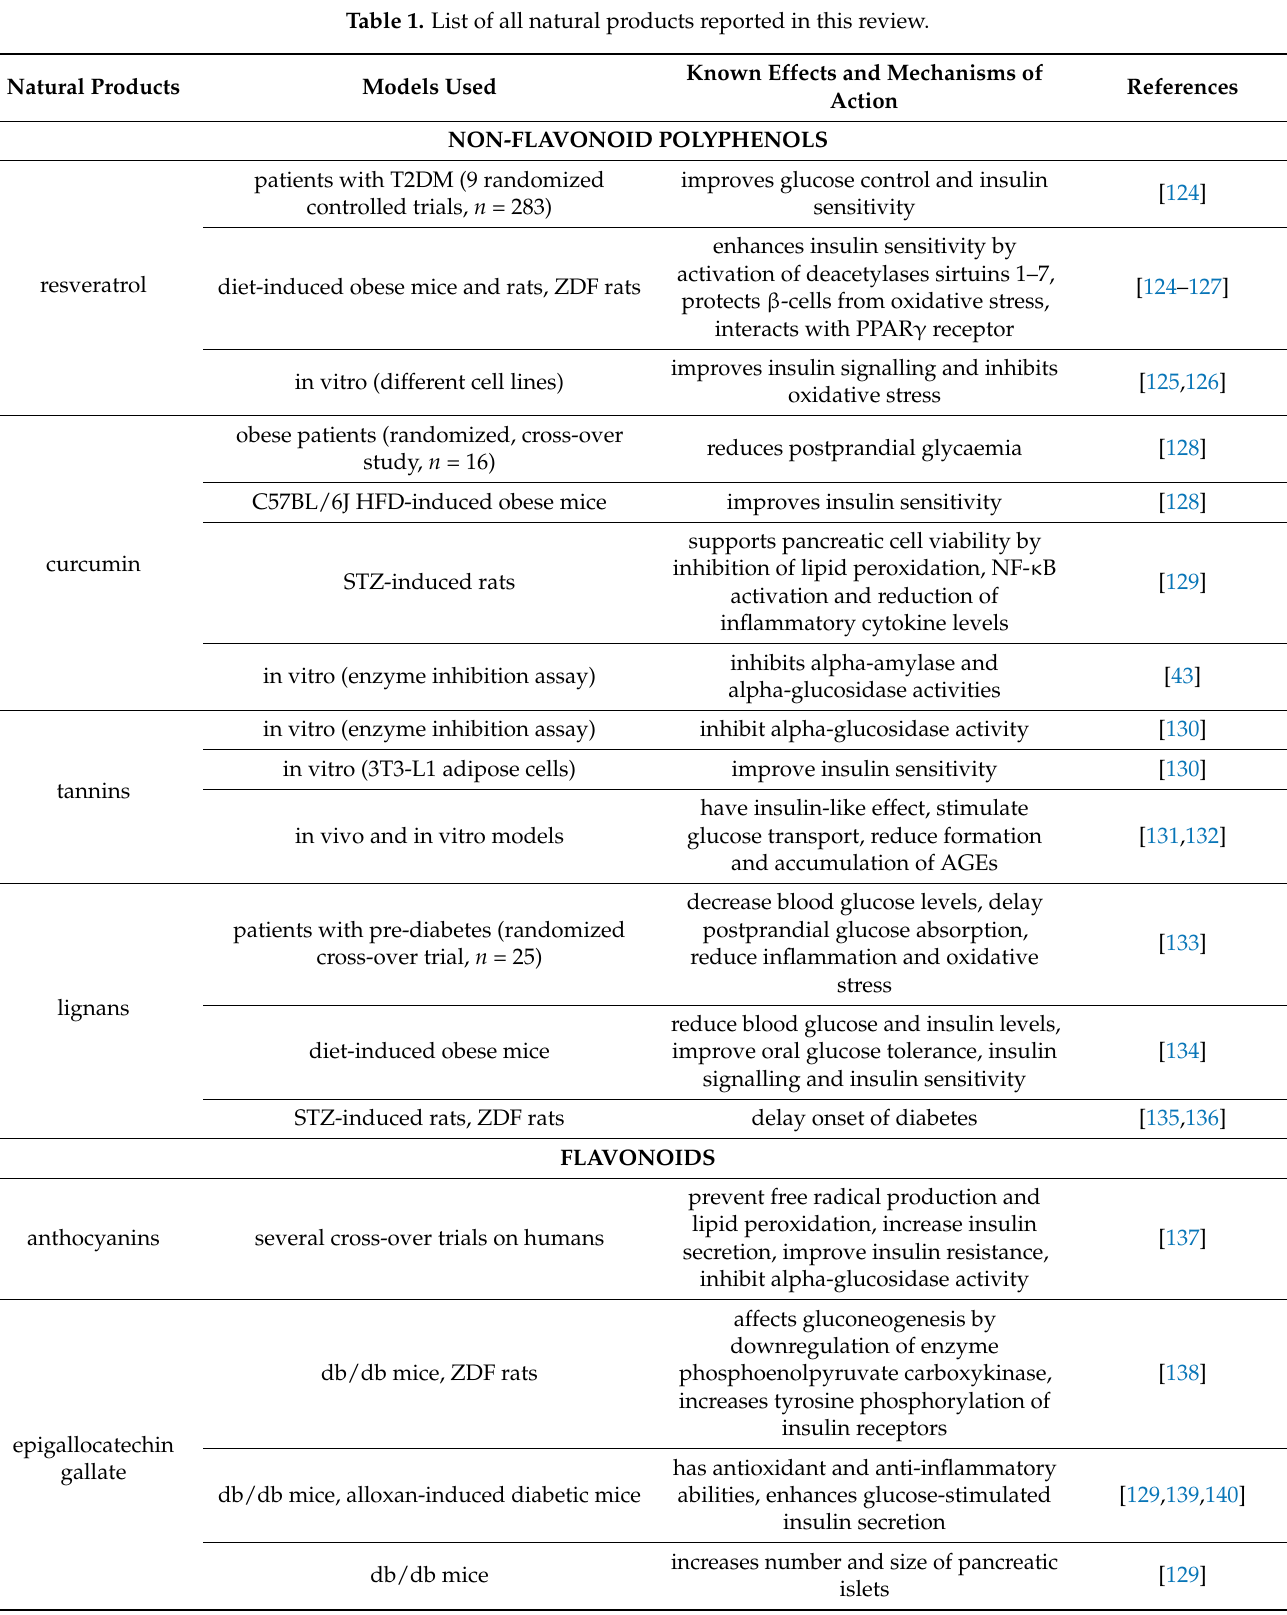
Table 1. List of all natural products reported in this